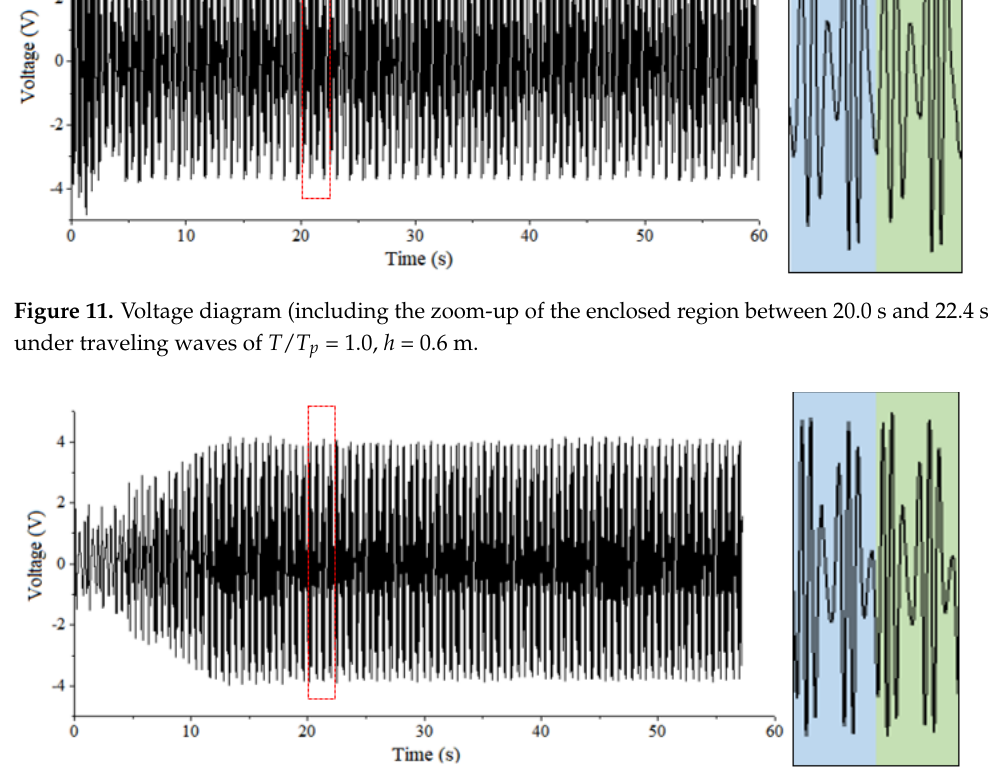
Figure 13. Voltage diagram (including the zoom-up of the enclosed region between 20.1 s and 22.5 s) under fully standing waves of T / T p = 1.0, h = 0.6 m. Figures 14–16 show the current time series diagrams measured under the conditions that the wave types are traveling waves, partial standing waves and fully standing waves, respectively. The trends in current variation time series could not be identified obviously in these three charts. After the wave field is stabilized in the flume, the peak value of instantaneous current measured under fully standing waves is the largest, second for par- tial standing waves and the smallest for traveling waves. Figure 14. Current diagram (including the zoom-up of the enclosed region between 20.0 s and 22.4 s) under traveling waves of T / T p = 1.0, h = 0.6 m.